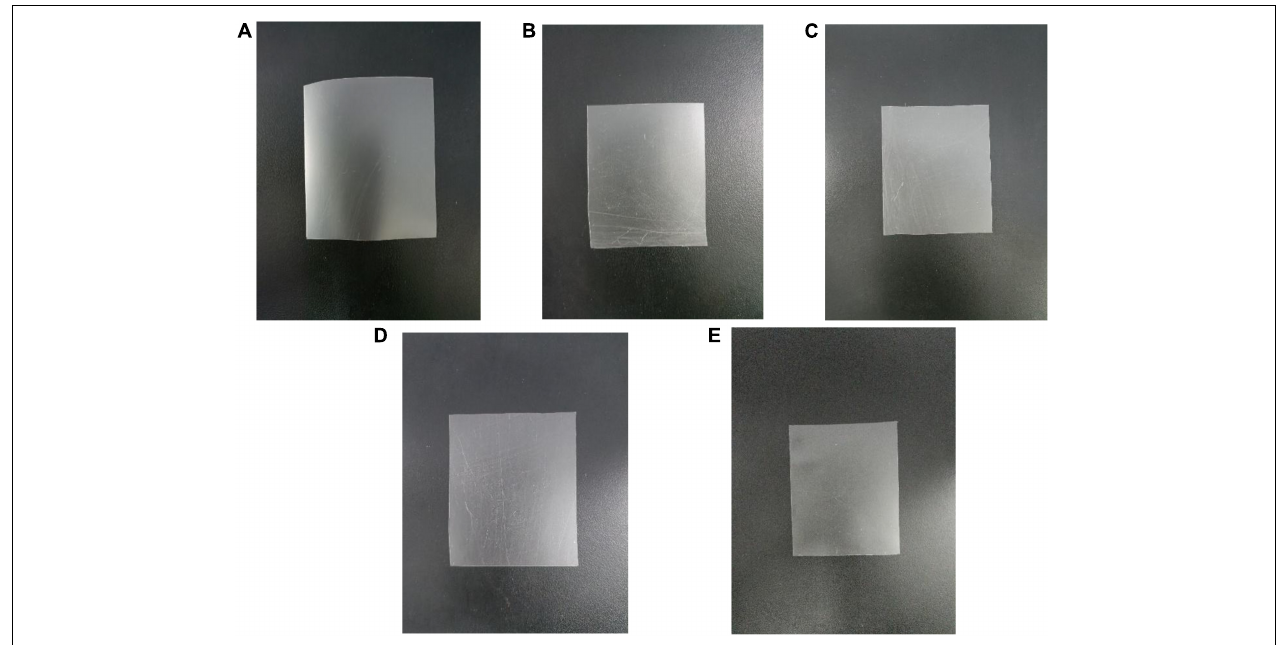
FIGURE 1 | Pictorial presentation of corn starch-based films supplemented with GLY and ERY (A) (0:4), (B) (1:3), (C) (2:1), (D) (3:1), and (E)